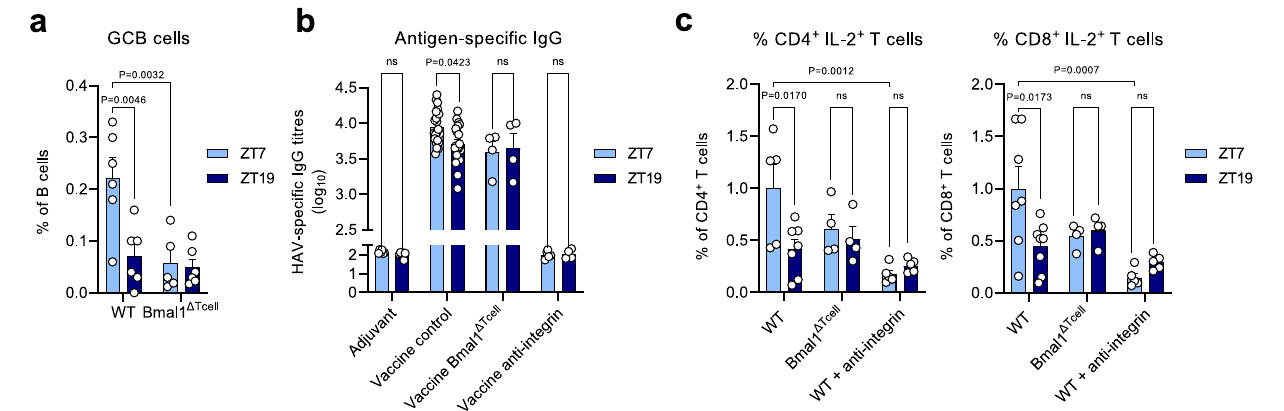
Fig. 5 | Rhythms inresponseto vaccination. a Germinalcenter B (GCB)cells as% of B cell fraction in the draining inguinal LN of T cell speci fi c Bmal1 − / − (BMAL1 Δ Tcell ) mice 14 days following vaccination with the commercial vaccine HAVRIX; n =5 – 6 mice, two-way ANOVA with Tukey ’ s post test. b Serum antigen-speci fi c antibody titers28daysaftervaccinationwiththecommercialvaccineHAVRIX; n =4 – 22mice,